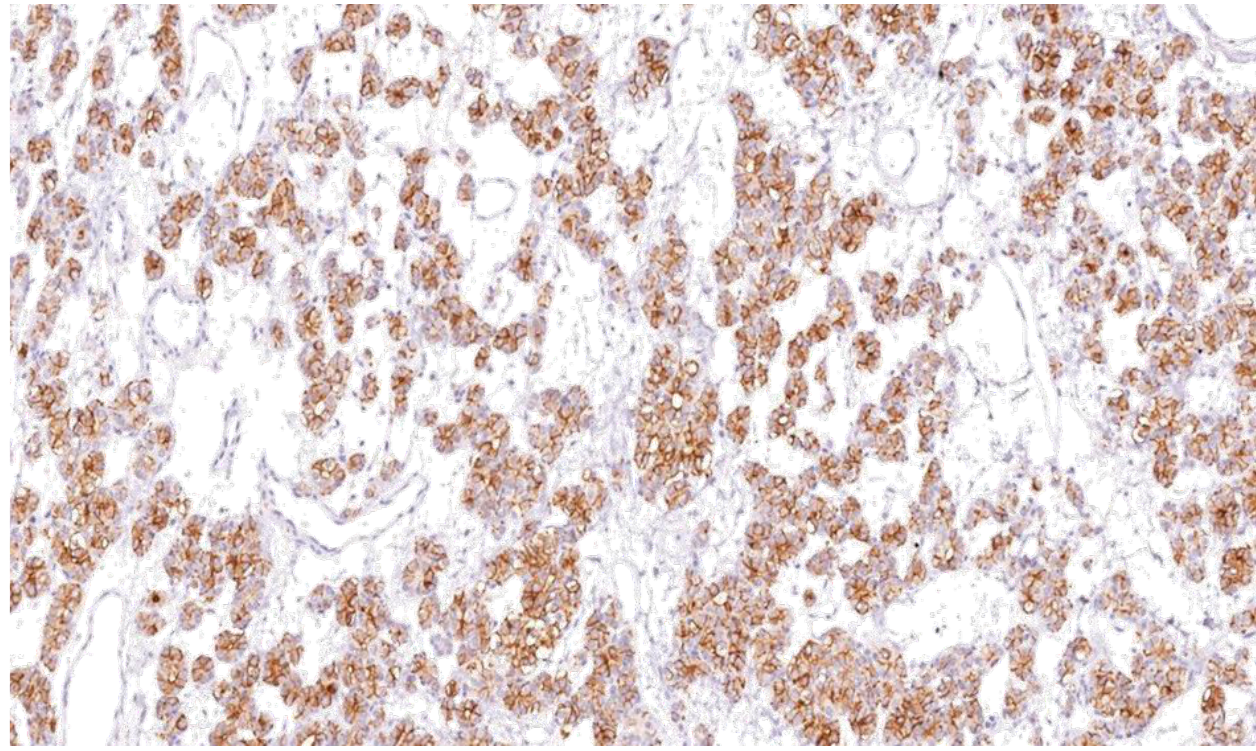
Figure 10. HBME-1 showing cytoplasmic and membranous staining as brown after IHC in papillary thyroidcarcinoma (×100).